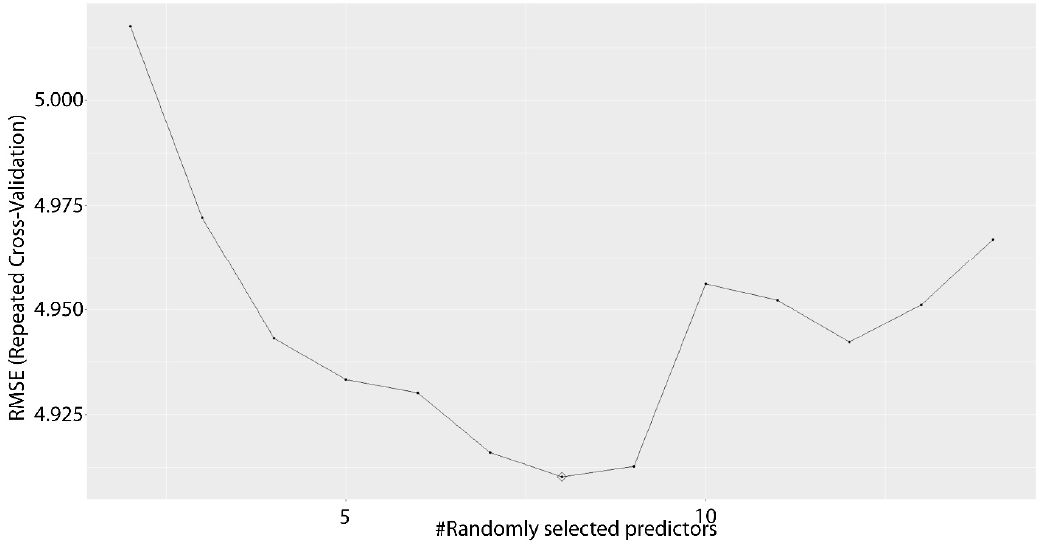
Figure 4. Training performances of the Random Forest model when seeking the best model to be selected.